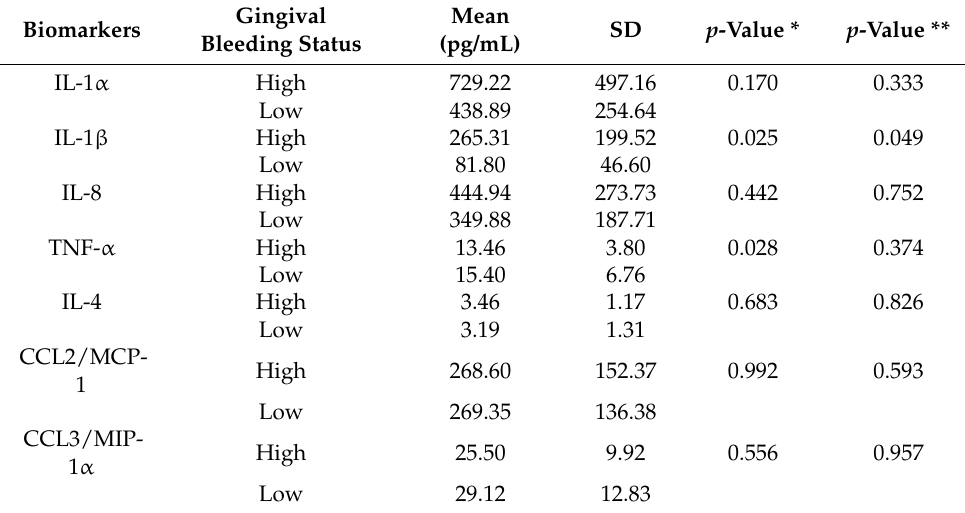
Table 2. Salivary cytokines associated with gingival bleeding.